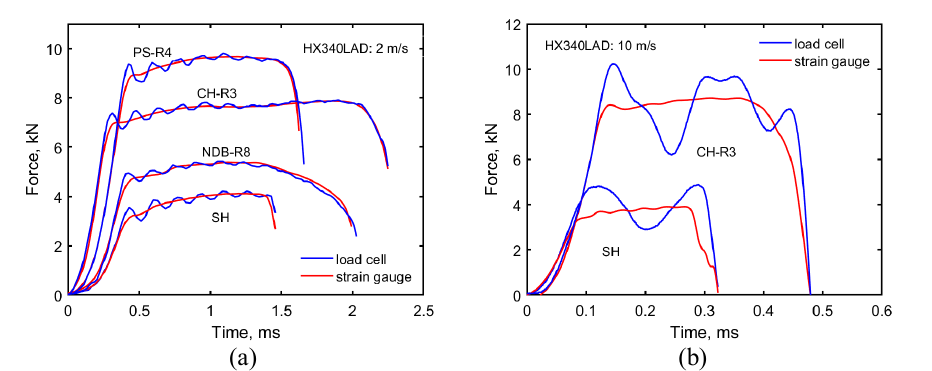
Fig. 3. Experimental force signal measured by the load cell and strain gauge. (a) 2 m/s; (b) 10 m/s.